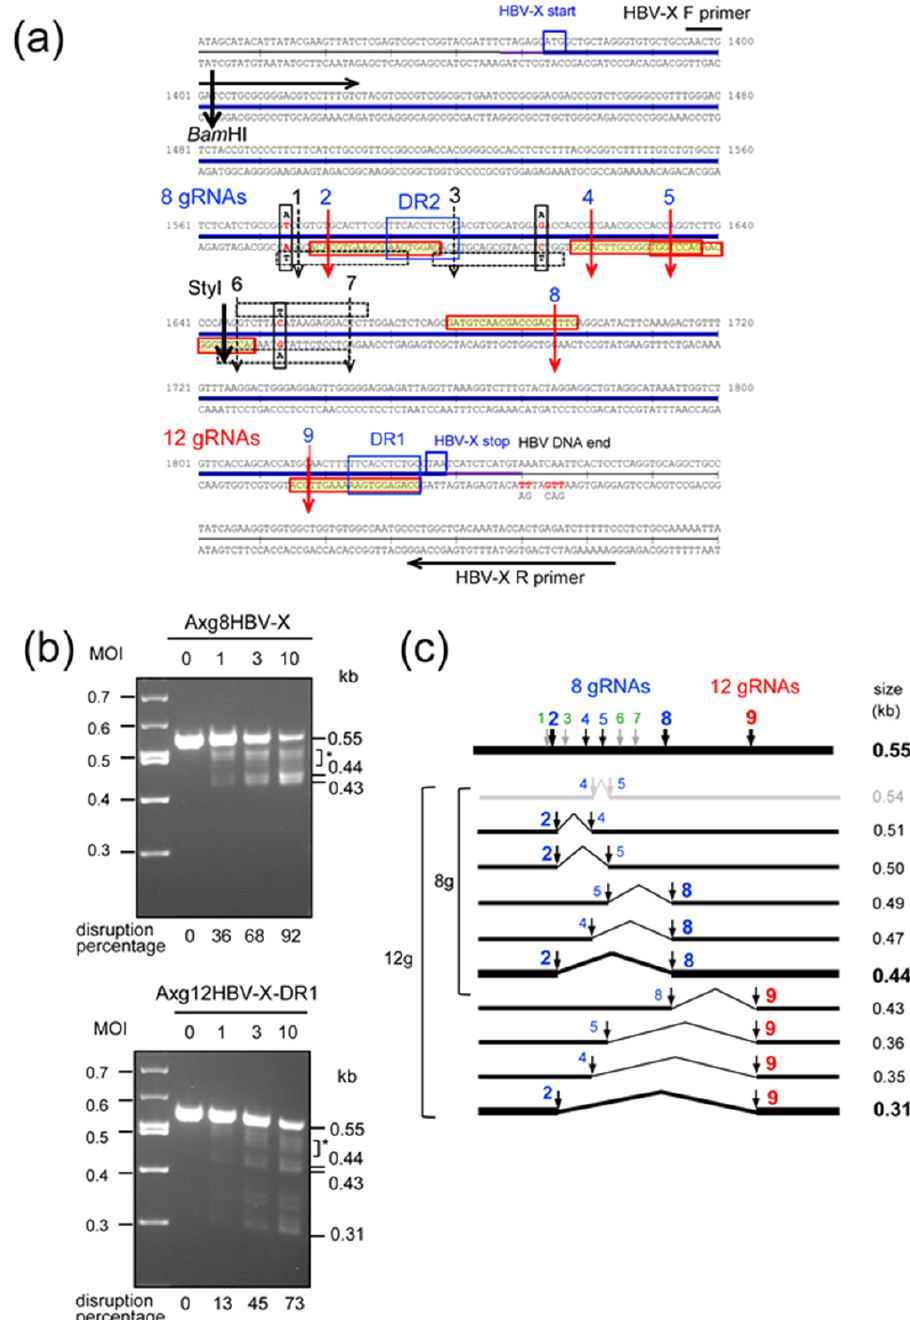
Figure 2. Disruption of the HBV X gene derived from a different patient using AdV expressing 8 and 12 gRNAs. ( a ) Sequences of the HBV X gene present in a chromosome of Gx11 cells. Blue bold line, X gene coding region. Three nucleotides differing between the two patients are shown as vertical boxes containing the diverse nucleotides in red. The blue numbers 2, 4, 5, 8, and 9 with bold and red vertical arrows show cut sites by Cas9. Their 20 nt recognition sequences are boxed in red. The black numbers 1, 3, 6, and 7 with thin and broken vertical arrows show the sites not cleaved by Cas9. Their 20 nt recognition sequences are boxed in black over and under the sequences. The PCR primers used for ( b ) are indicated at the top and bottom of this figure. ( b ) Multiple cleavages of the X gene using AdVs expressing 8 and 12 gRNAs. (Upper) Cleavage patterns using Axg8HBV-X. Gx11 cells were infected with Axg8HBV-X together with AxCBCas9 (AxCas9), and 3 days later, total cellular DNA was extracted and PCR was performed using the primer set shown in ( a ). The rates of disruption